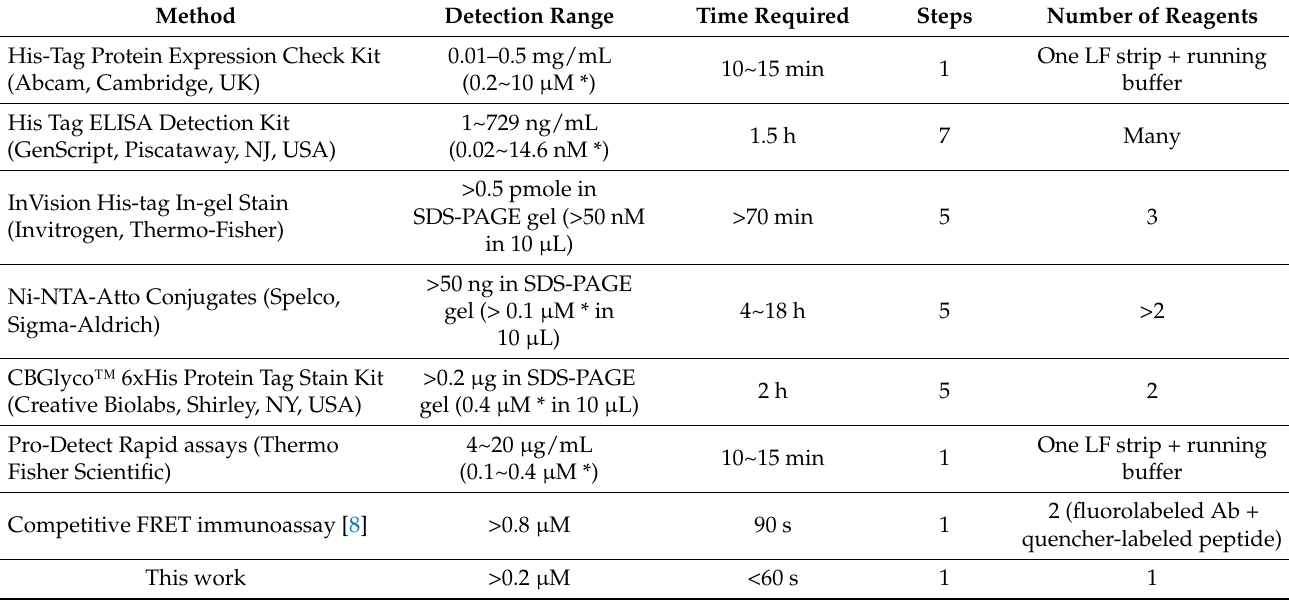
Table 5. Comparison of the reported methods to detect His-tagged